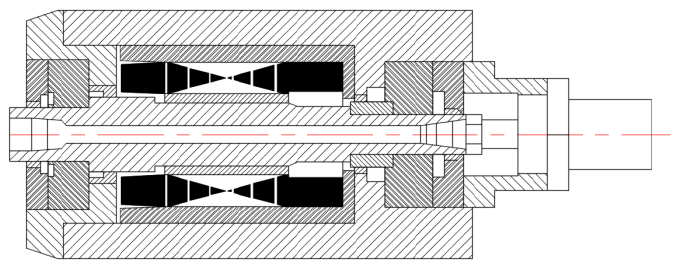
Figure 3. Grinding spindle profile.